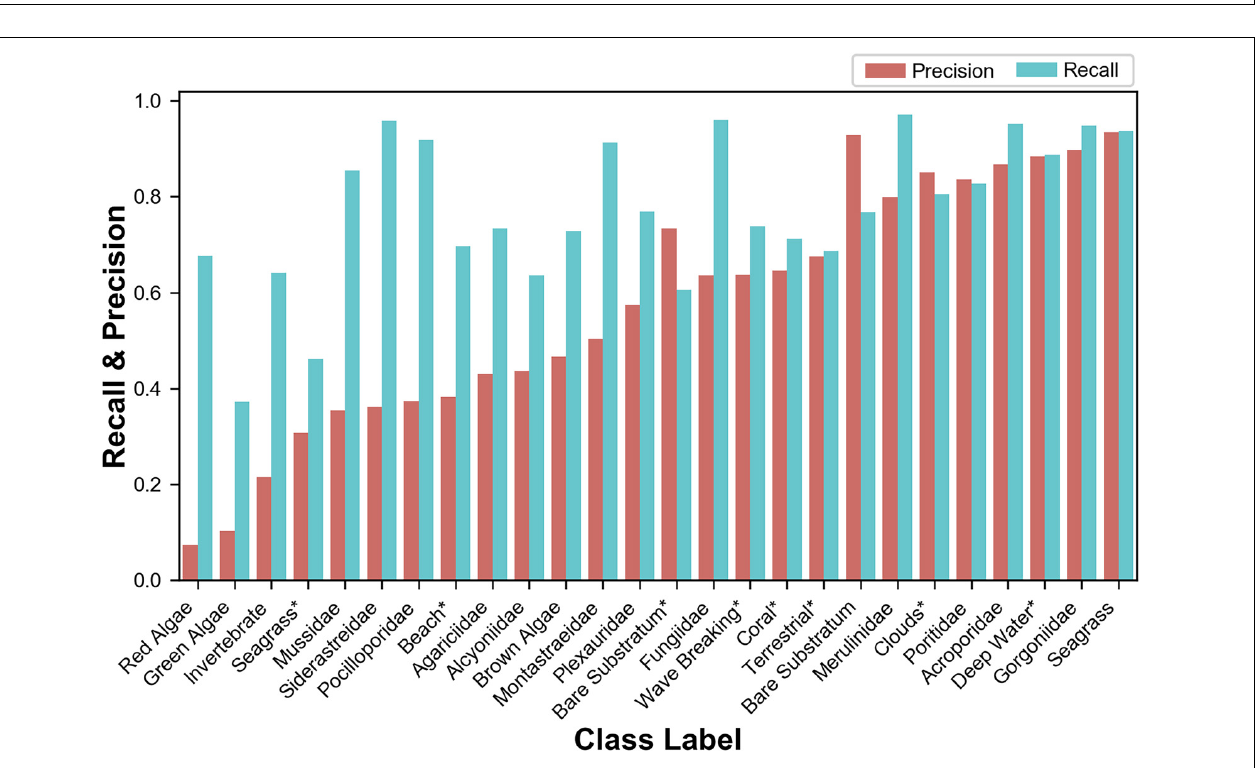
FIGURE 8 | Recall and precision per class label, sorted by Jaccard indices. Class labels with an asterisk indicate that the class label is used purely in satellite classifications.